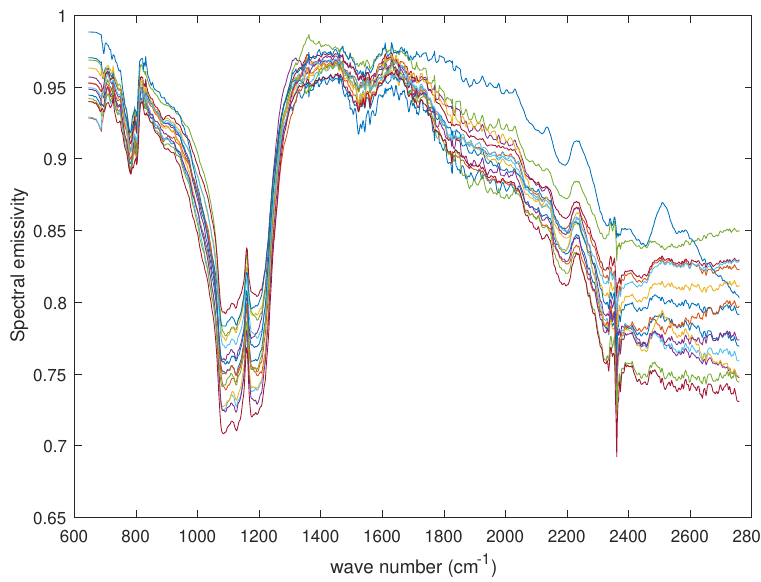
Figure 14. Retrieval of emissivity from IASI soundings over the gravel